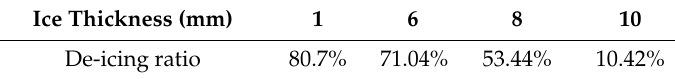
Table 4. Effect of ice thickness on de-icing ratio.